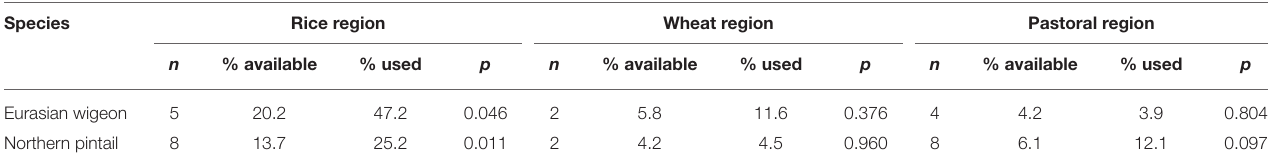
TABLE 3 | The mean percentage of Eurasian wigeon and northern pintail stopover sites (use) and flight corridors (available) composed of rice paddies (as depicted by Zhang et al., 2011) within China’s three agricultural regions (as defined by Pei et al., 2016). Species Rice region Wheat region Pastoral region n %